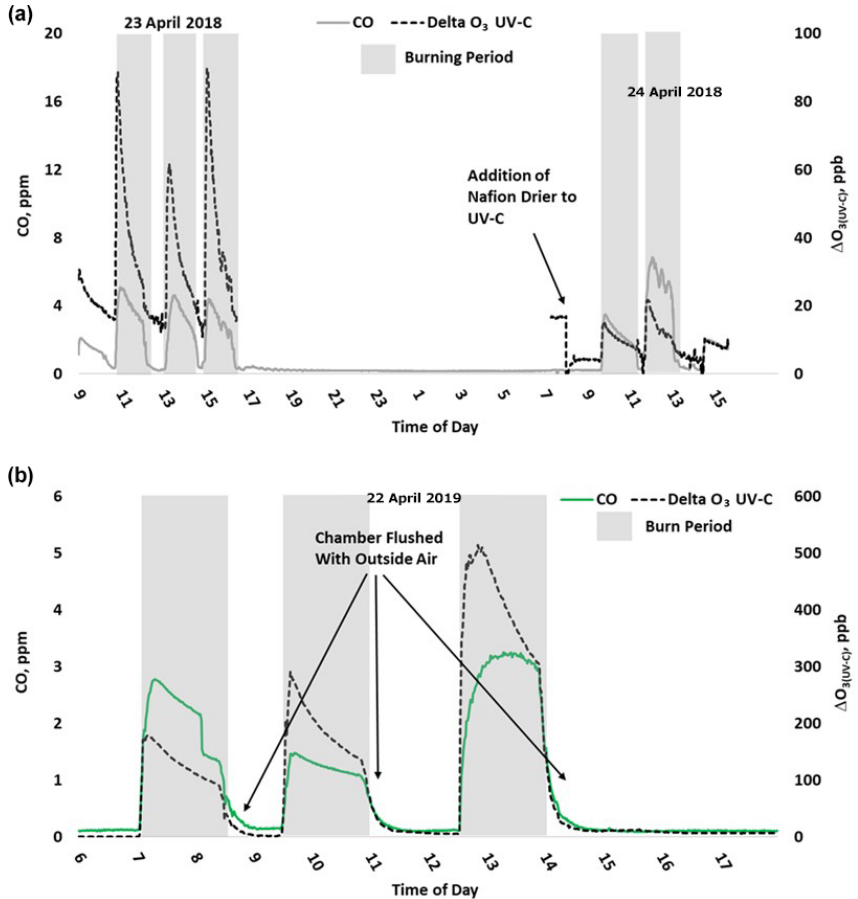
Figure 6. Time series example of USFS chamber burn (cid:49) O 3 (UV-C) and CO concentration results from 23–24 April 2018 (a) and 22 April 2019 (b)